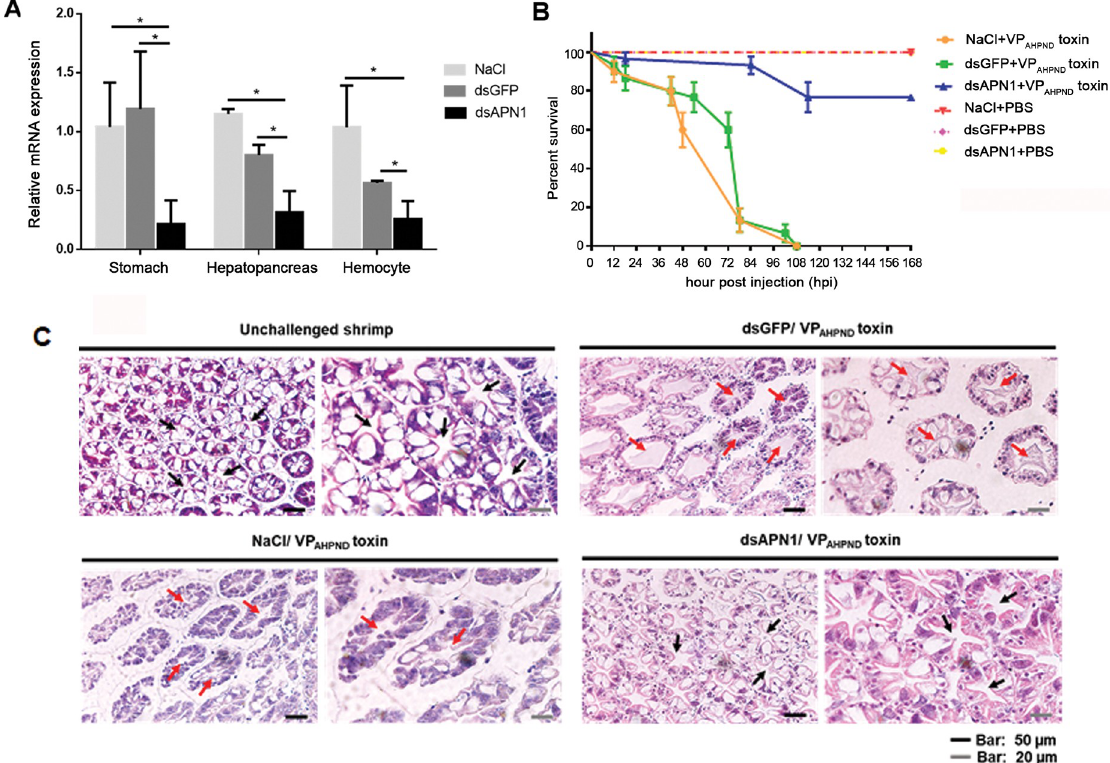
Fig 3. The effect of Lv APN1 silencing in AHPND-causing bacteria pathogenesis. (A) Confirmation of Lv APN1 gene knockdown in L . vannamei . The mRNA expression levels of the Lv APN1 gene in the stomach, hepatopancreas and hemocyte of shrimp injected with 0.85% NaCl, 20 μ g/g shrimp of dsGFP, or 20 μ g/g shrimp of dsAPN1 were determined by qRT-PCR and expressed in relative to EF-1 α . Each bar represents the mean ± SD, derived from triplicate experiments. Asterisks indicate significant difference ( P < 0.05). (B) Lv APN1 silencing reduced mortality in shrimp challenged with partially purified VP AHPND toxins. Cumulative mortality was monitored in 3 groups of 10 shrimp for each of the individual experimental conditions. NaCl-injected shrimp were challenged with partially purified VP AHPND toxin ( ), dsGFP-injected shrimp were challenged with partially purified VP AHPND toxin ( ), dsAPN1-injected shrimp were challenged